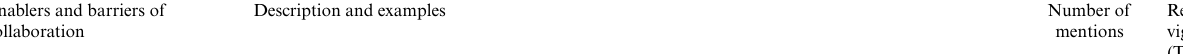
Table 4 . Factors, i.e., enablers and barriers, influencing collaboration in the Langkloof region. Enablers and barriers of